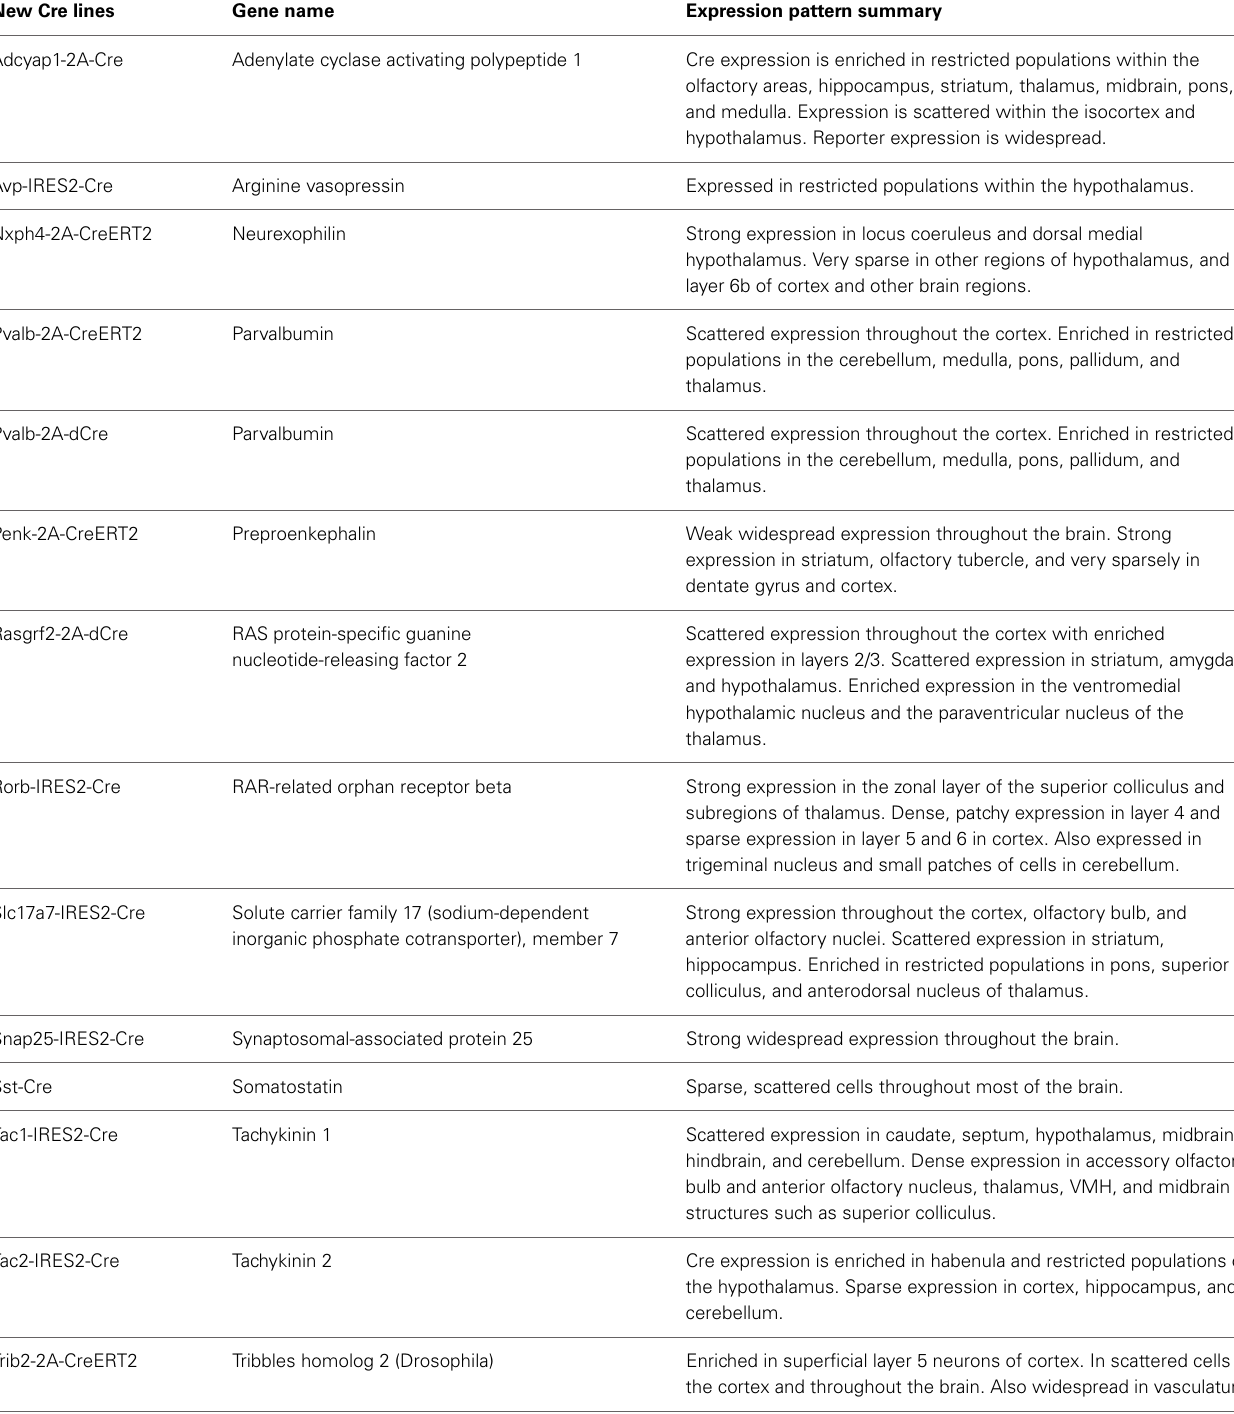
Table 1 | A list of newly generated Cre driver lines at the Allen Institute with a summary overview of the resulting whole brain expression patterns characterized by